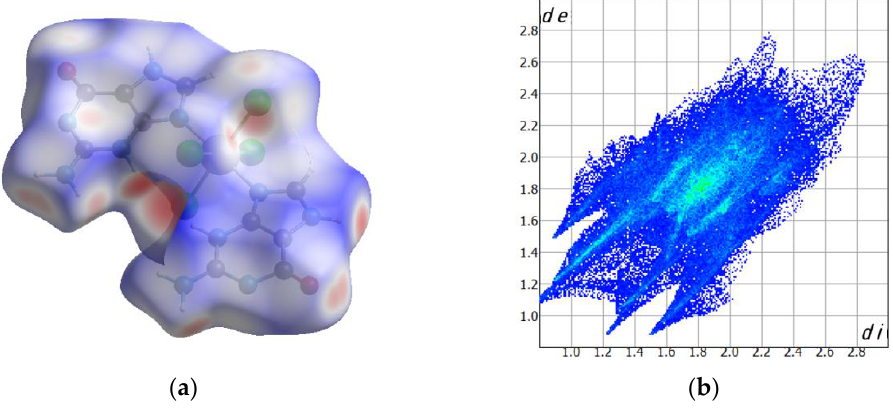
Figure 5. ( a ) Hirshfeld surface of 2 calculated through d norm function; ( b ) Fingerprint maps for compound 2 (see text).